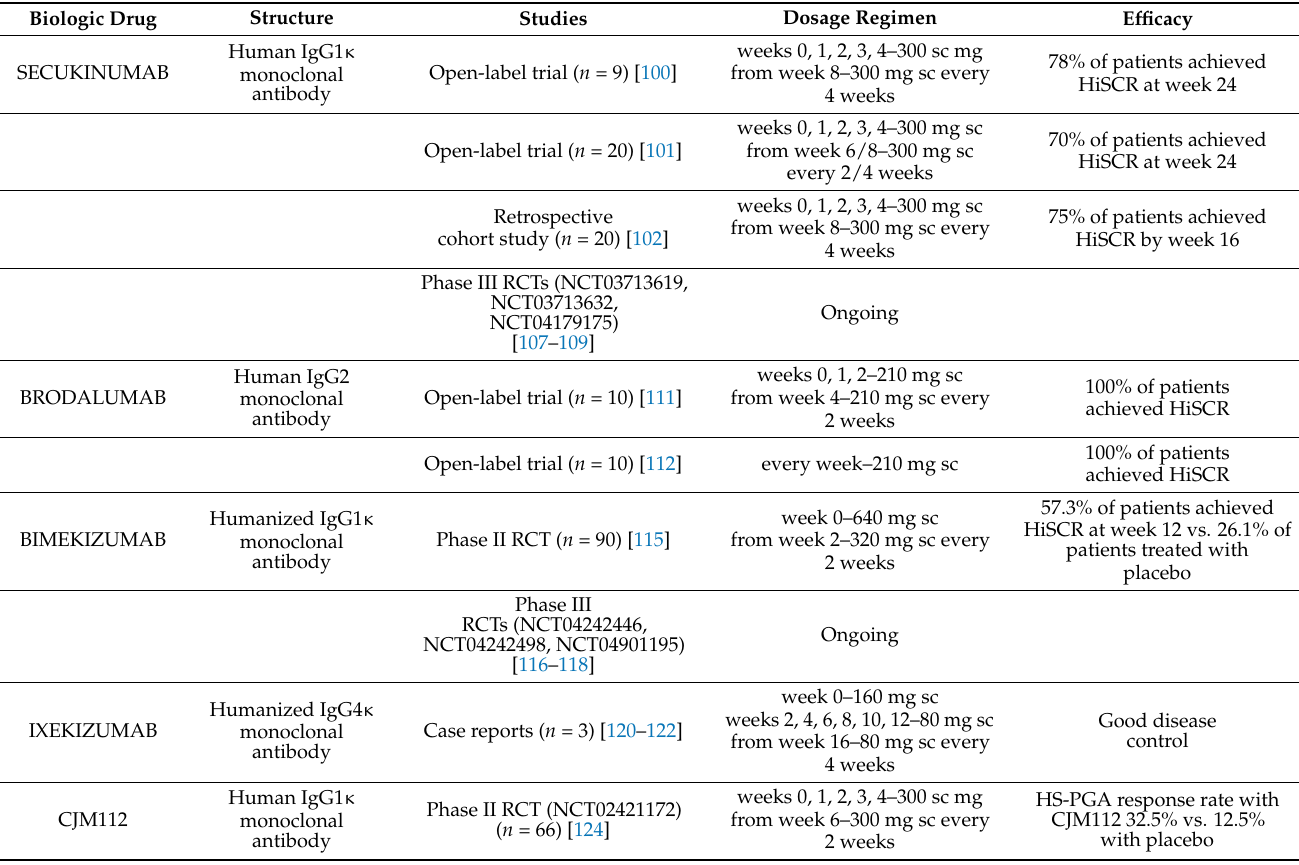
Table 4. Anti-IL-17 agents for HS